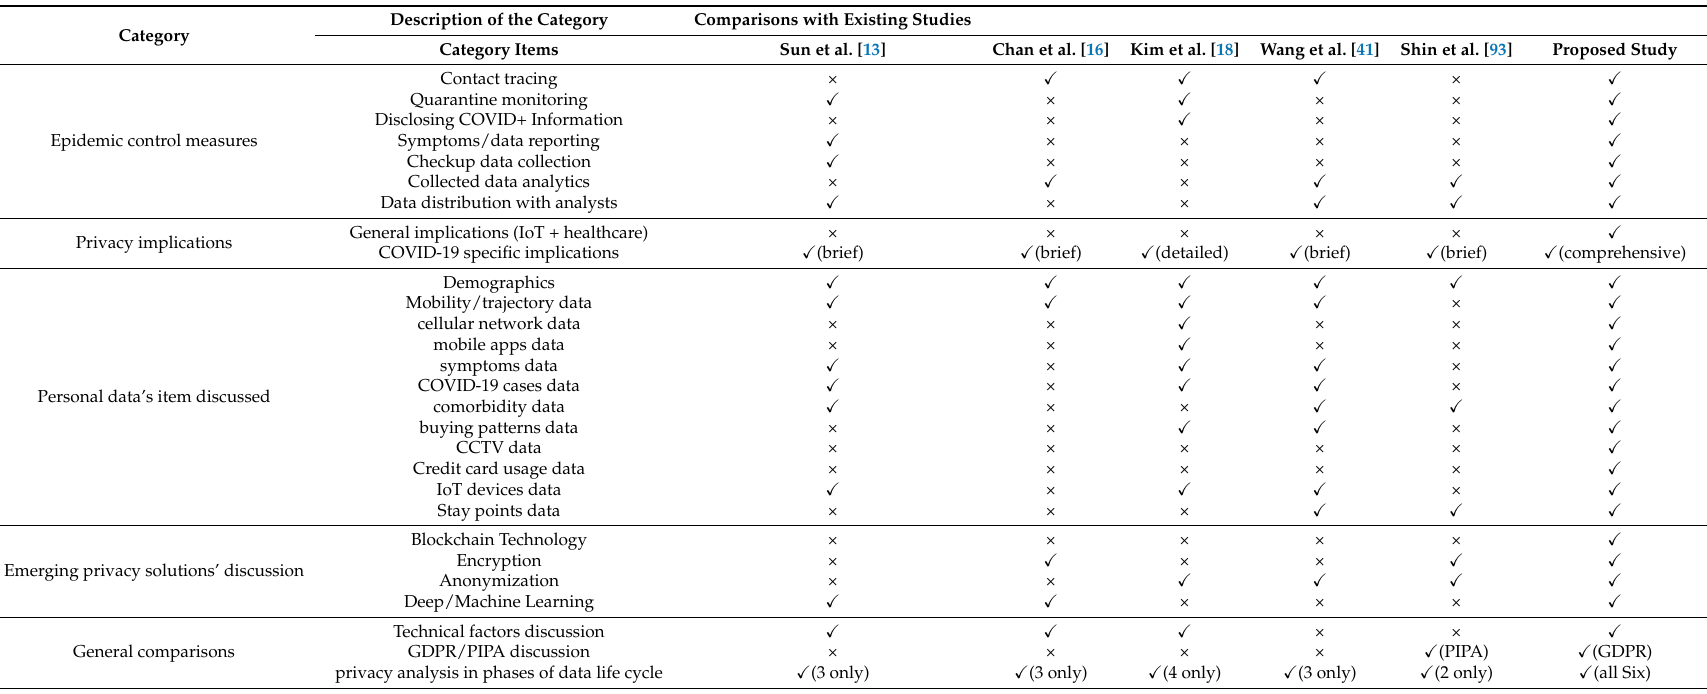
Table 1. Comprehensive comparisons with the existing and related